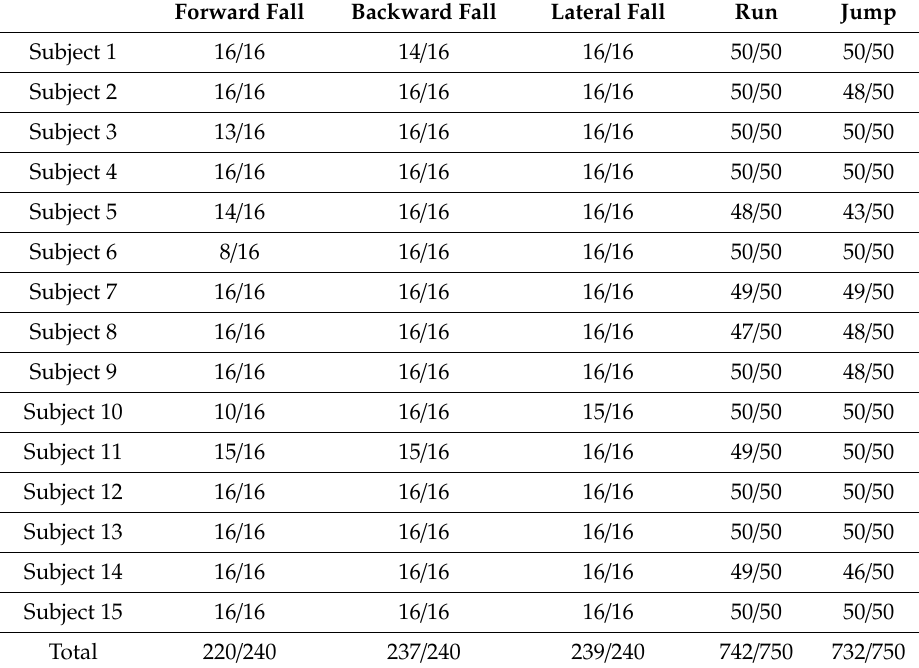
Figure 8. RMS acceleration and pitch and roll angles during ADL experiment. ( a ) Jump; ( b ) Stand–run–stand. Table 4. Experimental results of falling tests and ADL tests.